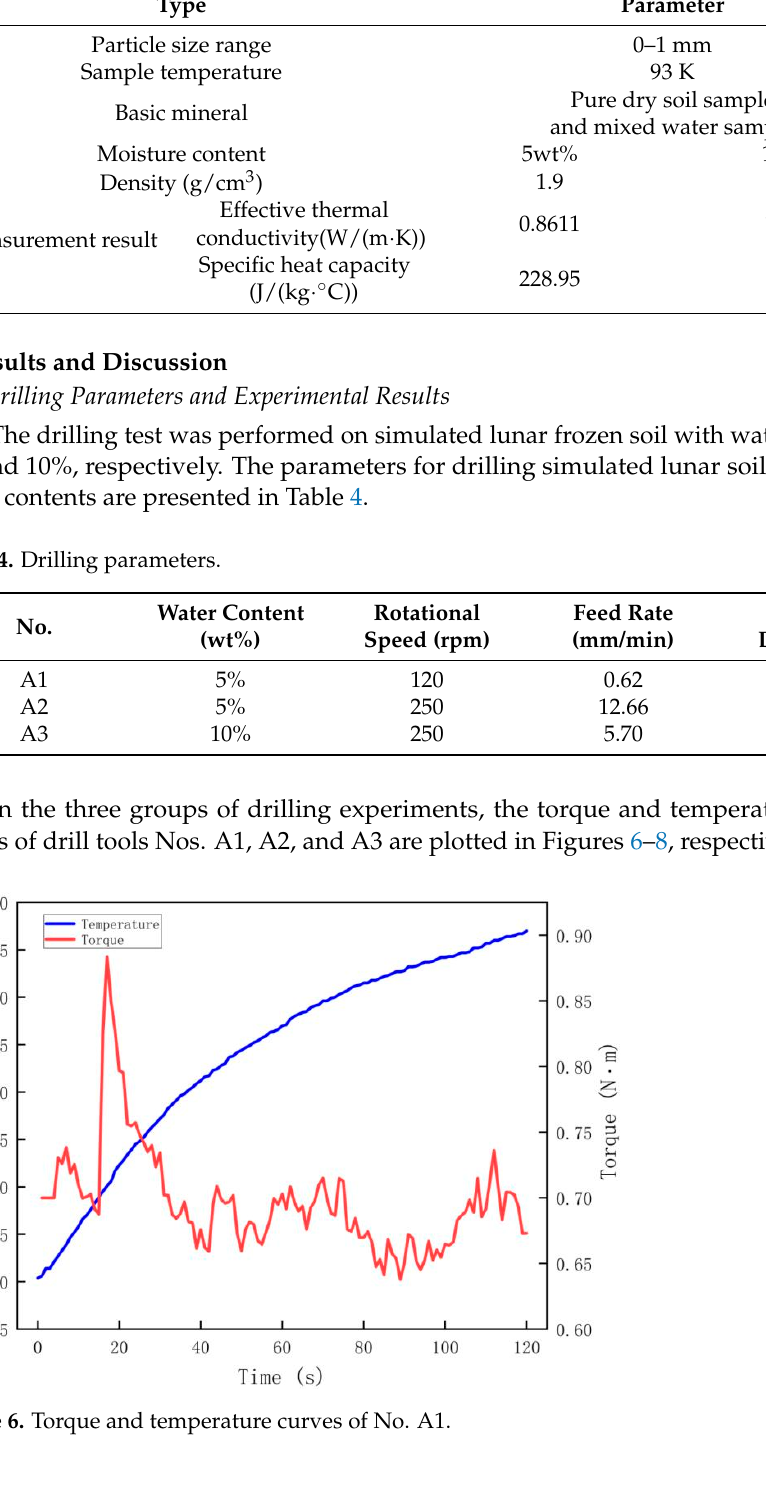
Figure 7. Torque and temperature curves of No. A2. Figure 8. Torque and temperature curves of No. A3.